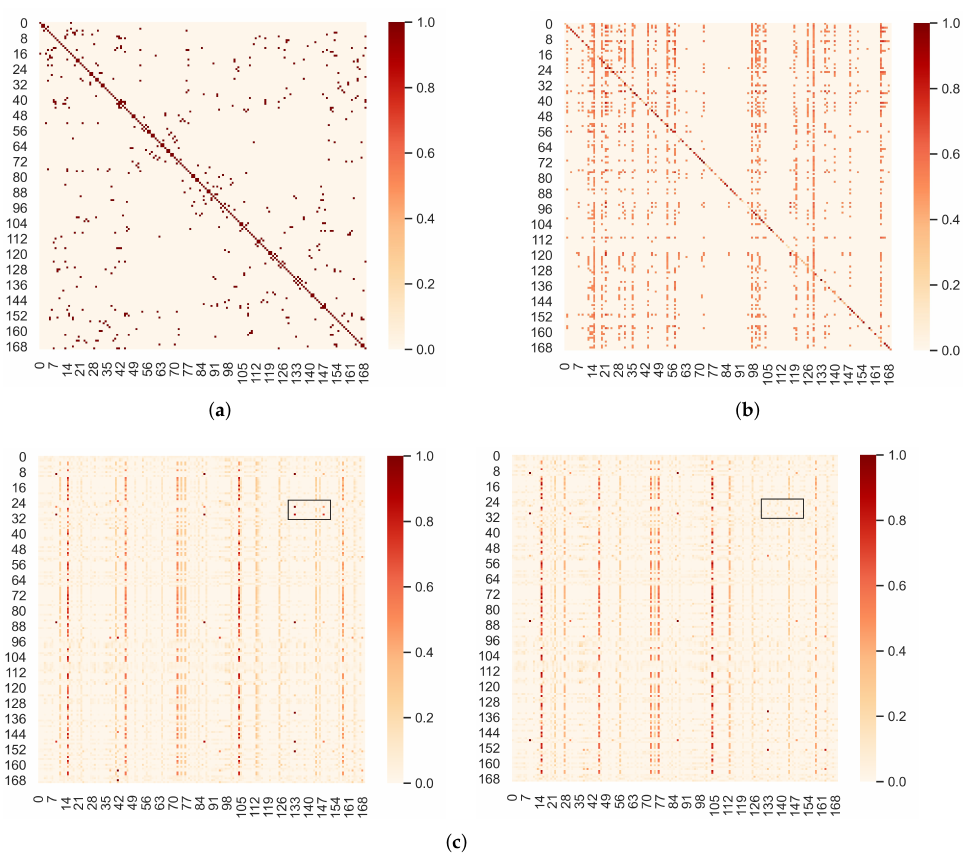
Figure 7. Graph structure visualization on PEMSD8. ( a ) Predefined graph structure, ( b ) learned adaptive adjacency matrix, ( c ) learned dynamic adjacency matrix at adjacent time intervals.